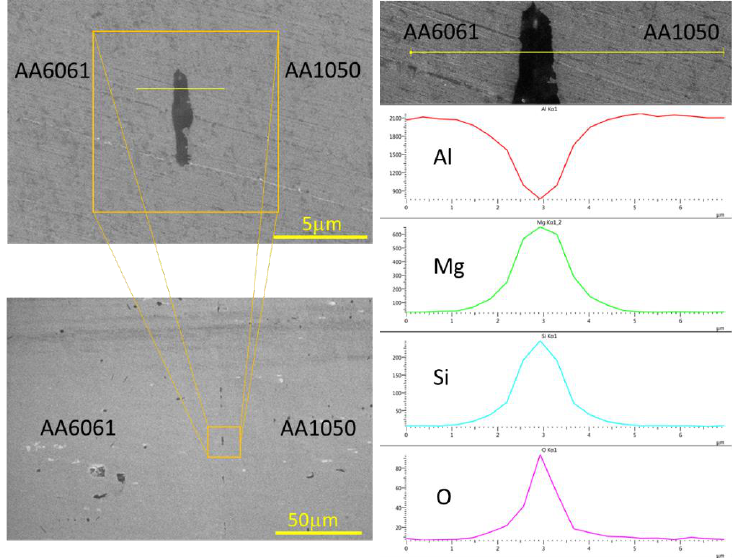
Figure 22. HRSEM EDS Line scan after 24 h DB in a vacuum oven of AA6061 – AA1050 couples.